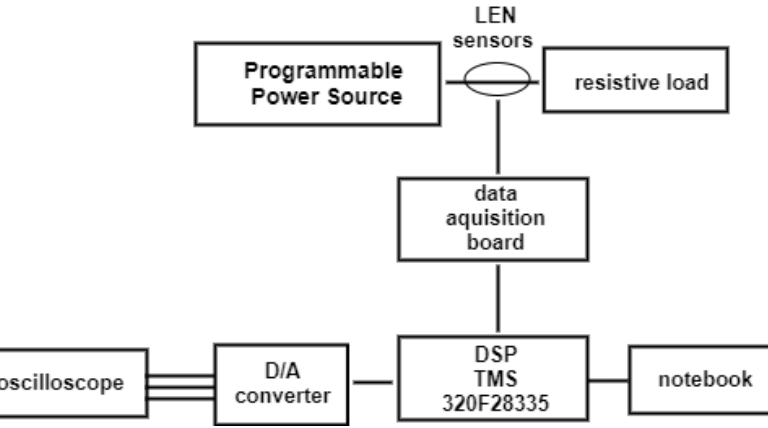
Figure 5. Block diagram—connections between components.